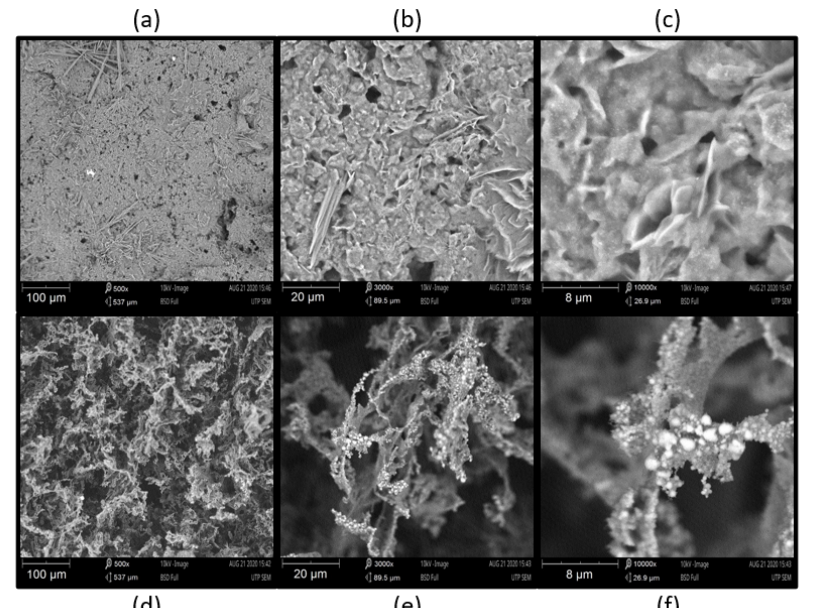
Fig. 3. SEM Imaging Microscopy of lignin-coated substrate versus OP-LSG. (a), Lignin at 100 µm resolution. (b), Lignin at 20 µm resolution. (c), Lignin at 8 µm resolution. (d), OP-LSG at 100 µm resolution. (e), OP-LSG at 20 µm resolution. (f) OP-LSG at 8 µm resolution.